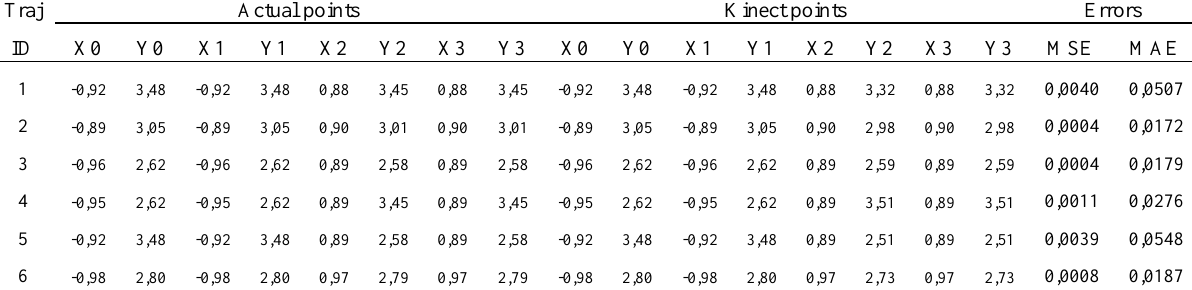
Table 2. Comparison between actual and Kinect generated trajectories, illustration for four point pairs and the corresponding mean squared and absolute